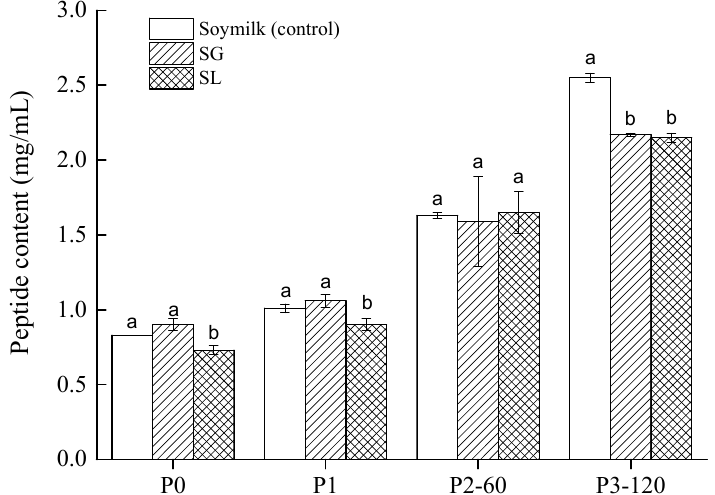
Figure 3. Peptide contents (<10 kDa) in soymilk (control), soymilk gel produced by GDL (SG), and soymilk gel induced by LAB (SL) samples. Within the same digestion phase, different lowercase letters indicate significant differences ( p < 0.05). P0 represents the sample before in vitro GIS digestion; P1 represents the sample after buccal digestion; P2-5 and P2-60 indicate samples collected at 5 min and 60 min of gastric digestion, respectively; and P3-30 and P3-120 indicate samples collected at 30 min and 120 min of intestinal digestion, respectively.